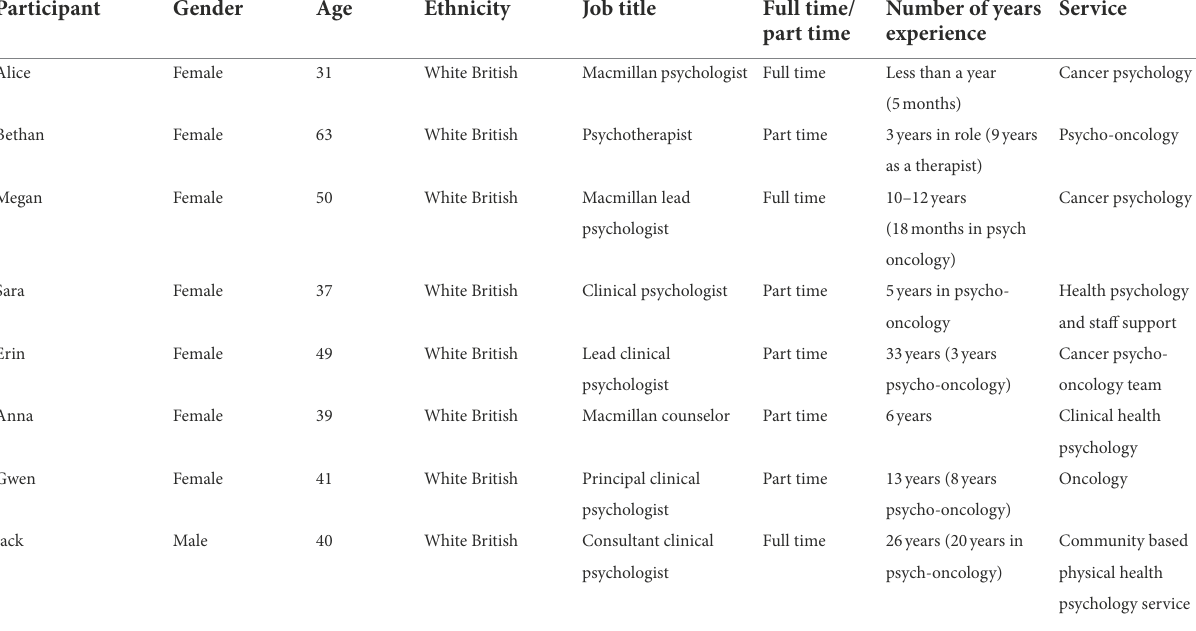
TABLE 1 Participants